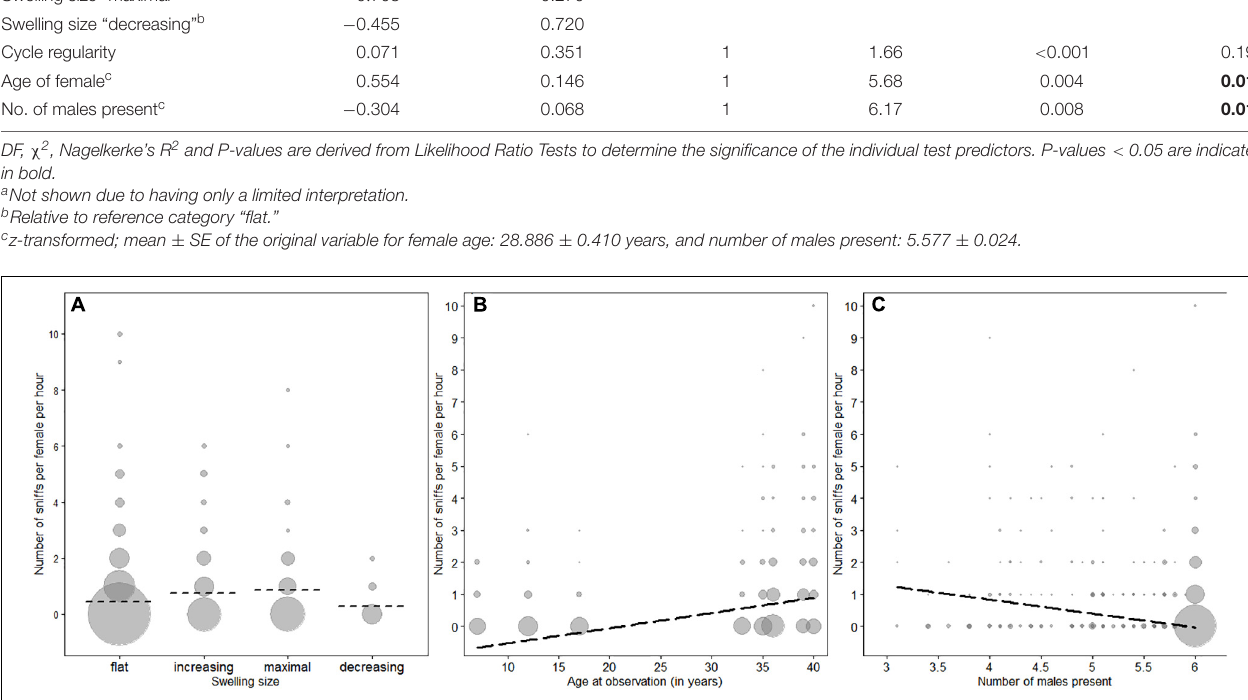
TABLE 2 | Results of the negative-binomial GLMM with the number of sniffs females received by the six males as response variable and swelling size, cycle regularity, age of female, and male presence as test predictors. Term Estimate SE DF χ 2 R 2 P Intercept − 0 . 875 0.231 Swelling size